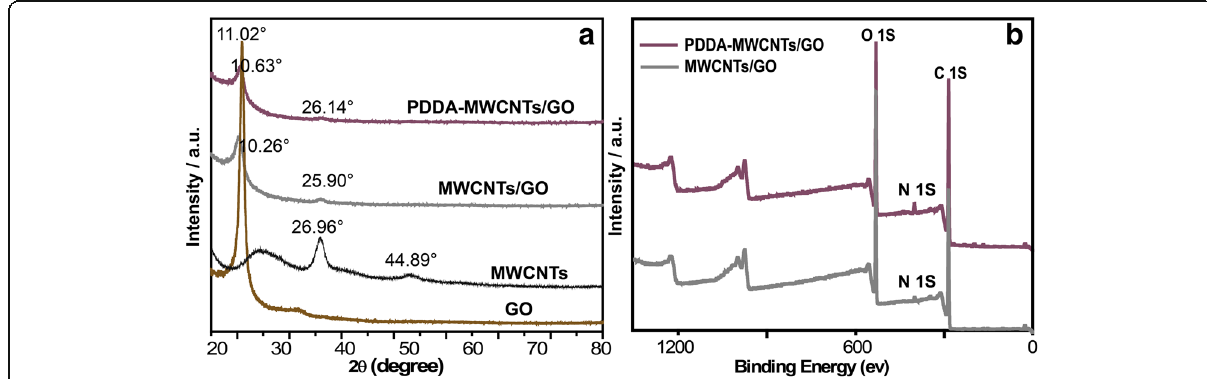
Fig. 5 a The XRD patterns of GO, MWCNTs, MWCNTs/GO, and PDDA-MWCNTs/GO. b XPS spectra of MWCNTs/GO and PDDA-MWCNTs/GO